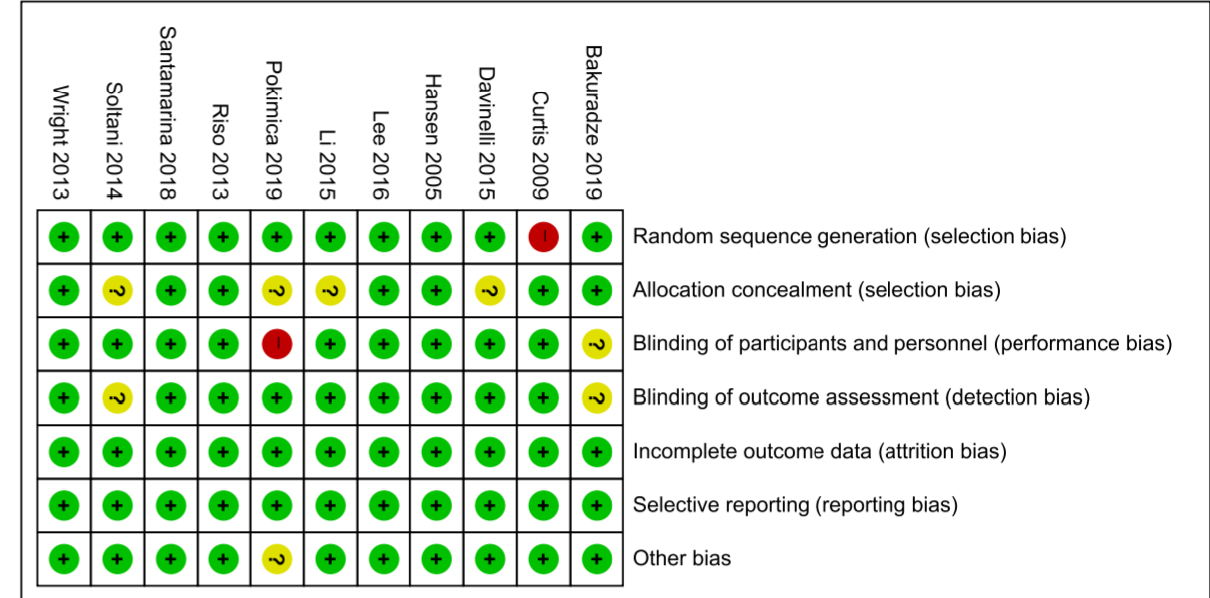
Figure 2. Risk of bias (ROB) results of quality assessment of the 11 RCTs. Risk of bias levels; low (green or “+”), Unclear (yellow or “?”), High (red or “-“)